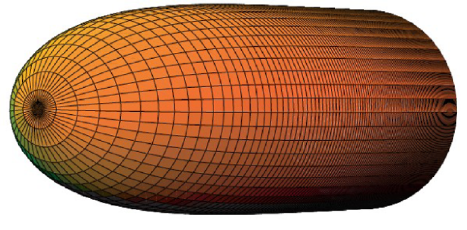
Figure 2 . Visualization of the 2 D manifold with metric